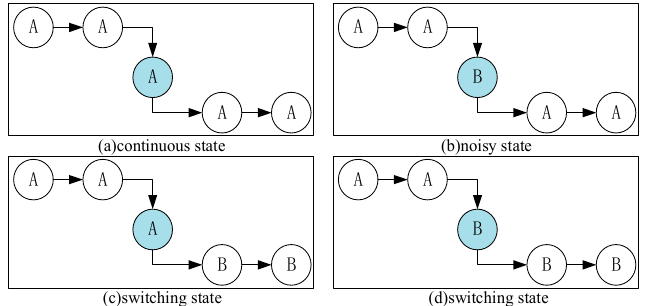
Figure 8. Instances of the three categories.